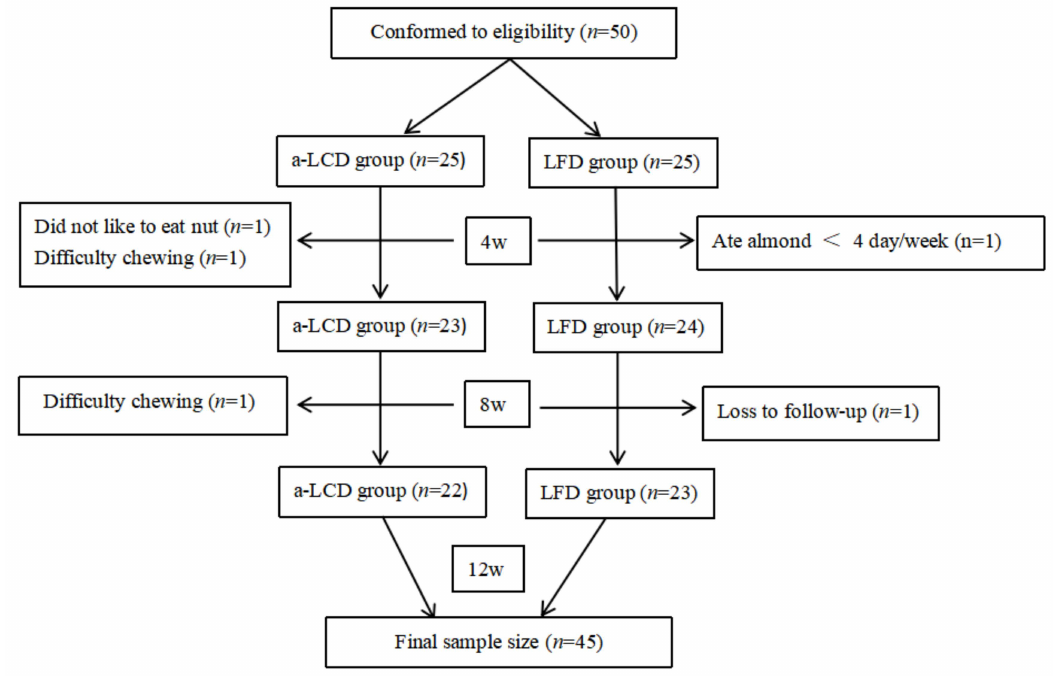
Figure 1. Flow diagram of the participants included in the study (a-LCD (almond-based low carbohydrate diet); LFD (low fat diet). Table 1. Baseline